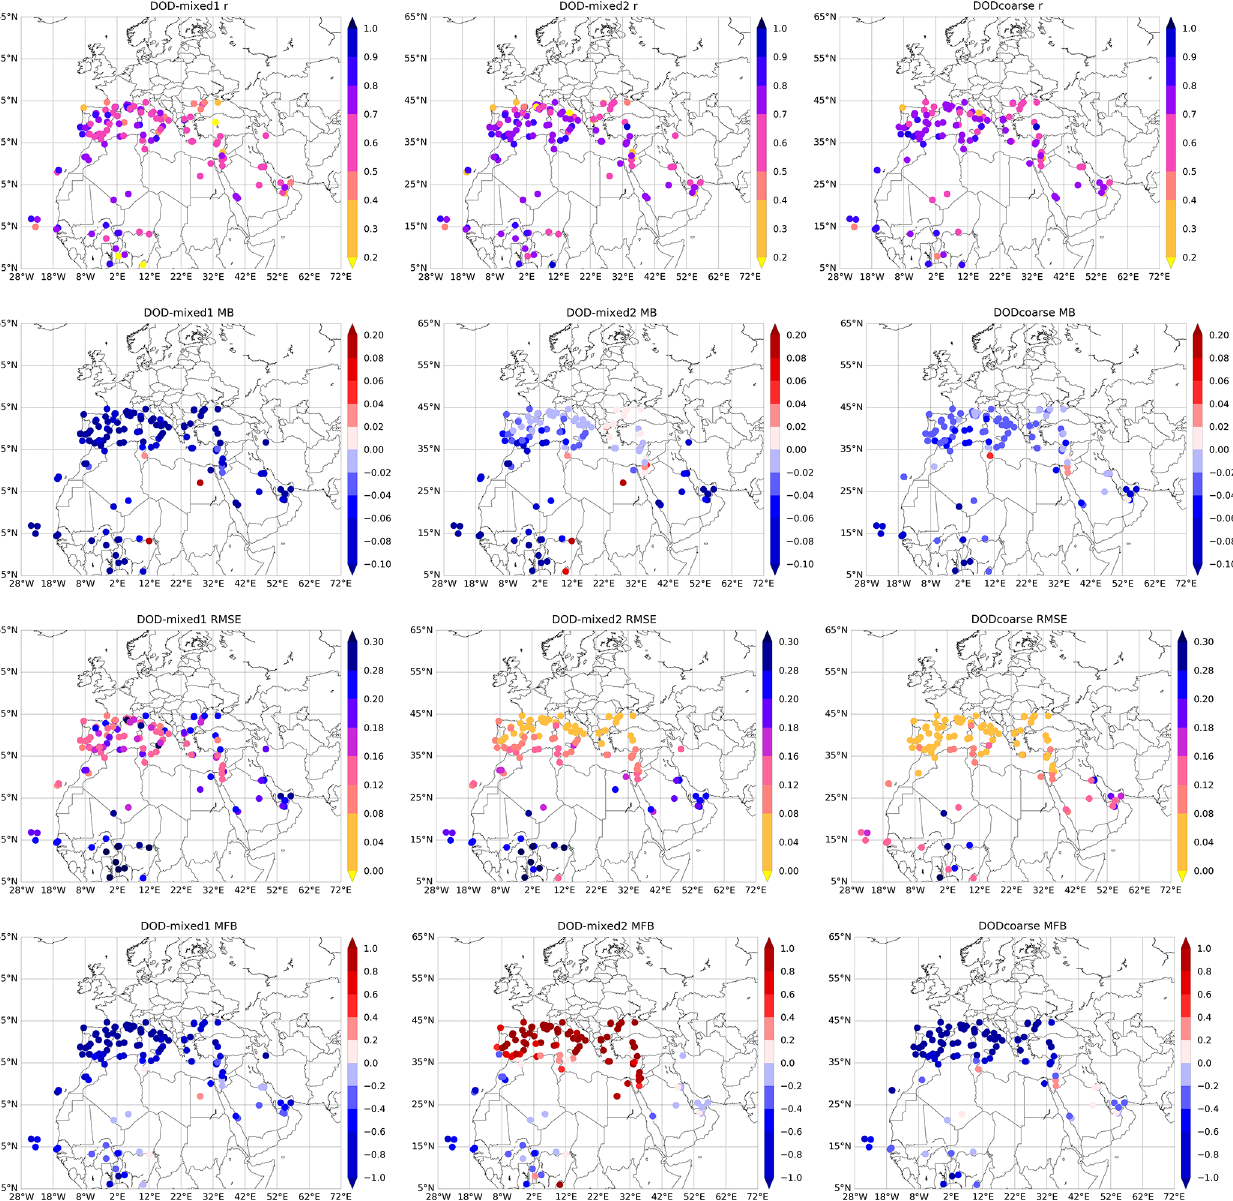
Figure 12. Maps of verification statistics ( r , MB, RMSE, MFB, from top to bottom) of the analysis DOD (first and second columns) and DOD coarse (third column) versus AERONET dust-filtered AOD (Table 6): DOD-mixed1 (left), DOD-mixed2 (middle) and DOD coarse (right) calculated for the whole period (2007–2016). The results are obtained using 3-hourly collocated reanalysis and observation values (see also Table